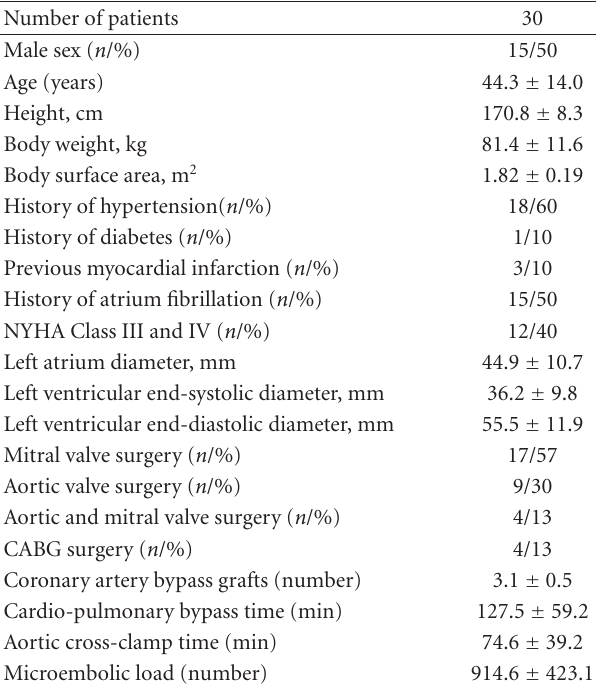
Table 1: Patient